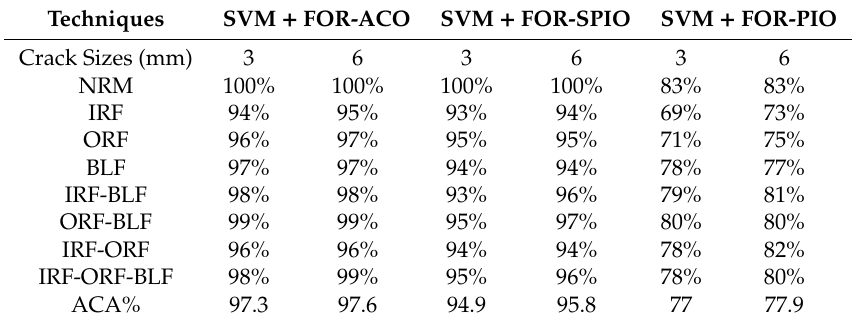
Table 10. The Accuracy of Multi-Type Fault Identification When the Torque Speed is 300 RPM. Techniques